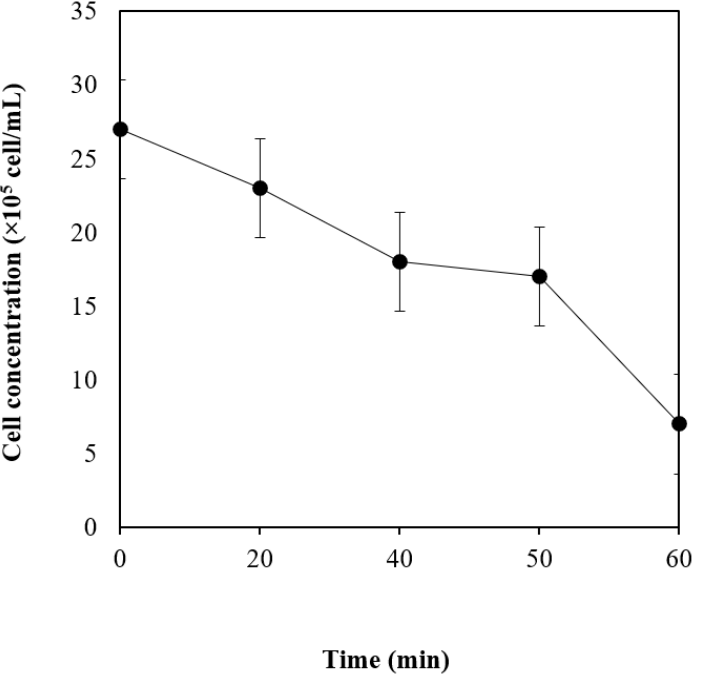
Figure 1. Cell count of CbCt after mutagenesis with EMS .